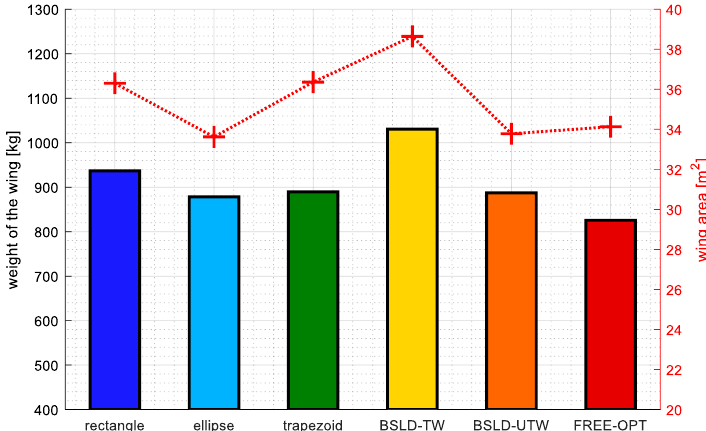
Figure 10. Estimated weight of the optimized